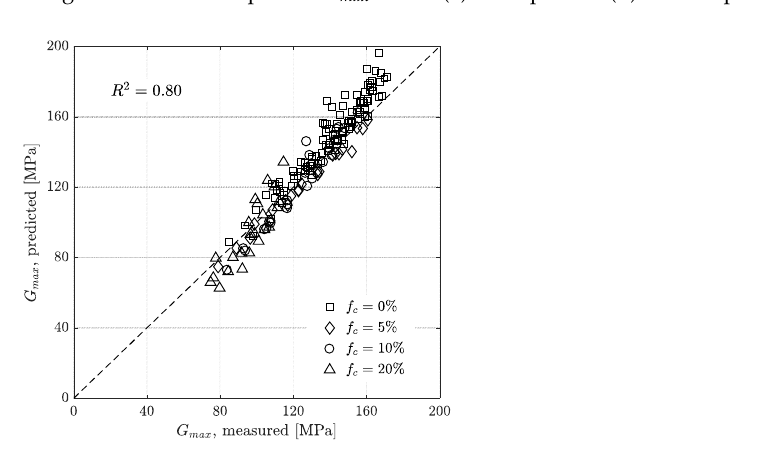
Figure 12. Comparison of the measured and predicted G max values considering different fines con- tent.